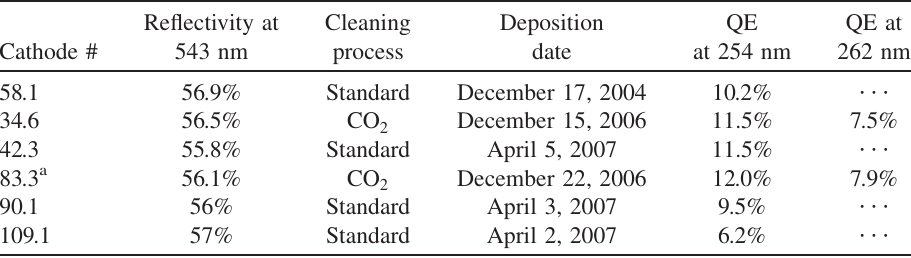
TABLE II. Various production parameters of Cs PITZ.